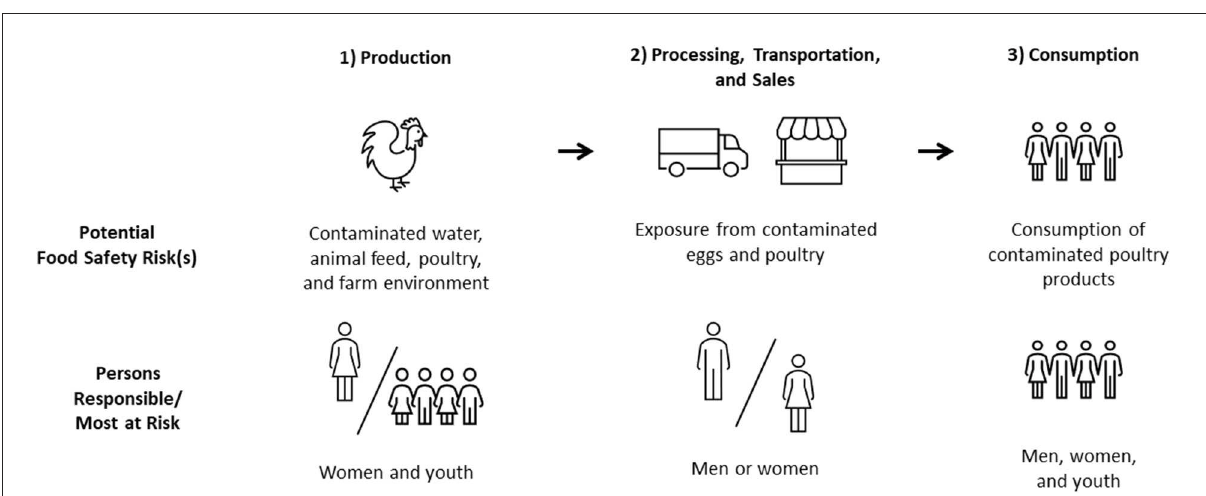
FIGURE1 Responsibilities and risks for men, women, and youth in the poultry value chain in